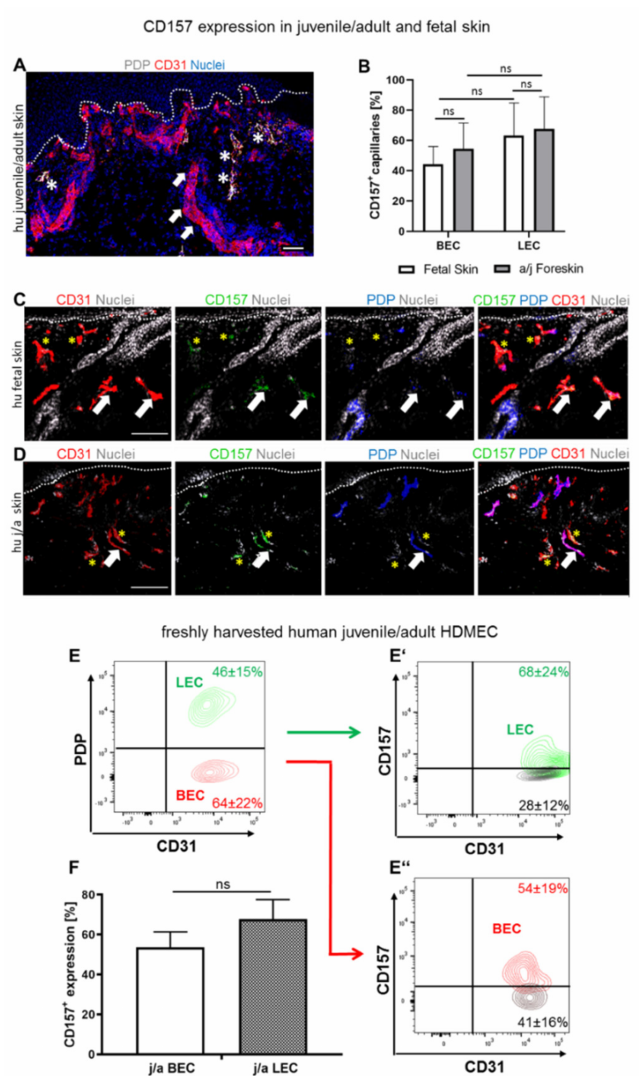
Figure 1. CD157 expression in human juvenile/adult (j/a) and fetal (f) skin. ( A ) Representative immunofluorescence image used for the differentiation between blood (CD31 + /PDPN; white arrows) and lymphatic (CD31 + /PDPN + ; white asterisks) capillaries (scale bar: 50 µ m). Dotted line indocate dermo-epidermal junction. ( B ) The fraction of CD157 + capillaries in fetal (f) and juvenile/adult (j/a) foreskin skin sections was assessed based on the total number of blood and lymphatic capillaries (n = 7). ( C , D ) Human f and j/a skin was stained for endothelial-specific CD31, CD157 and PDPN markers, (scale bars: 100 µ m). Asterisks indicate CD31 + PDP - CD157 + capillaries, white arrows point to CD31 + PDP + CD157 + capillaries. Dotted lines delineate dermo-epidermal junction. ( E – F ) Sorting ( E , E” ) and quantification ( F ) of freshly isolated CD157 + and CD157 − BEC and LEC using FACS sorting ( p = 0.6144, ns; n = 7). Statistical tests were performed using two-way